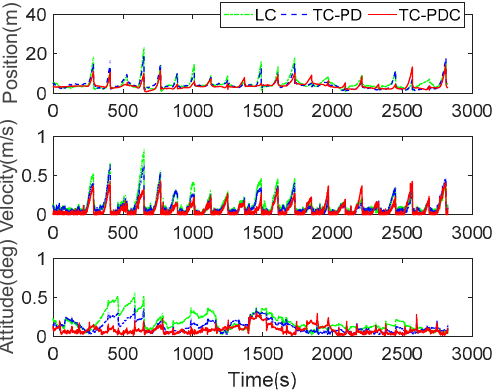
Figure 8. Navigation errors of LC, TC-PD, and TC-PDC with several 60-s simulated GNSS outages.